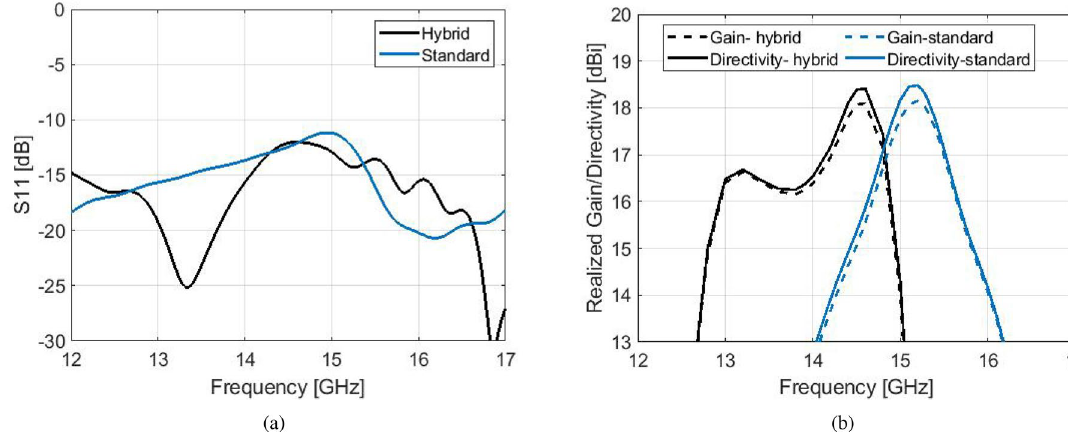
Figure 10. Simulation results of an optimized hybrid Bull’s Eye antenna with enhanced 3-dB gain bandwidth and comparison with a standard Bull’s eye antenna ( N = 5 ) with similar directivity/gain. ( a ) S 11 . ( b ) Directivity and realized gain.